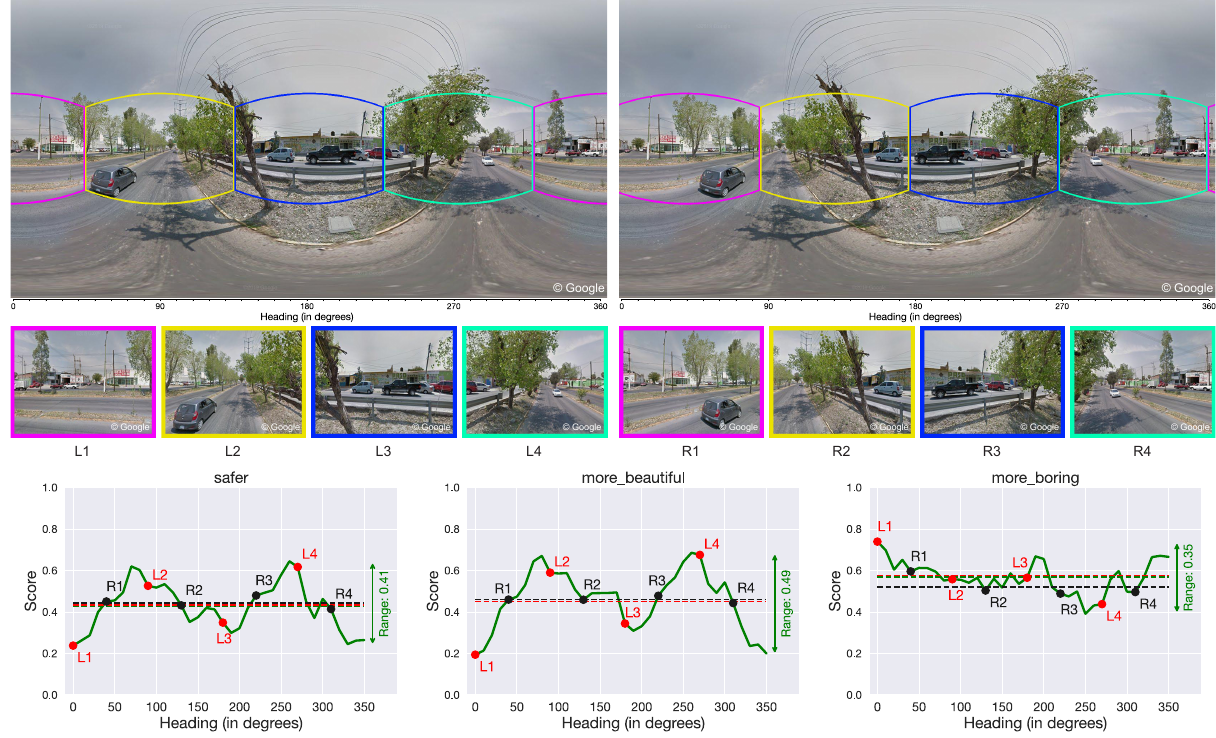
Figure 1. At the top left, a 360° panorama from Google Street View in equirectangular projection with four windows oriented at 0°, 90°, 180°, 270° (L1-L4) . At the top right, the same panorama is represented with four windows shifted by 40°(R1-R4), i.e. oriented at 40°, 130°, 220°, 310°. The perspective images corresponding to the windows are below each panorama. At the bottom, the scores for three of the six categories from the PP2 dataset are represented. The thirty-six scores obtained with the sliding window method are in green. The mean scores are represented by the horizontal dashed lines. In red is the mean of L1-L4, in black of R1-R4, and in green of the thirty-six scores. The mean score is about the same no matter the sampling chosen, but the scores have widely different distributions. L1-L4 windows give scores with high variability whereas the scores for R1-R4 are almost